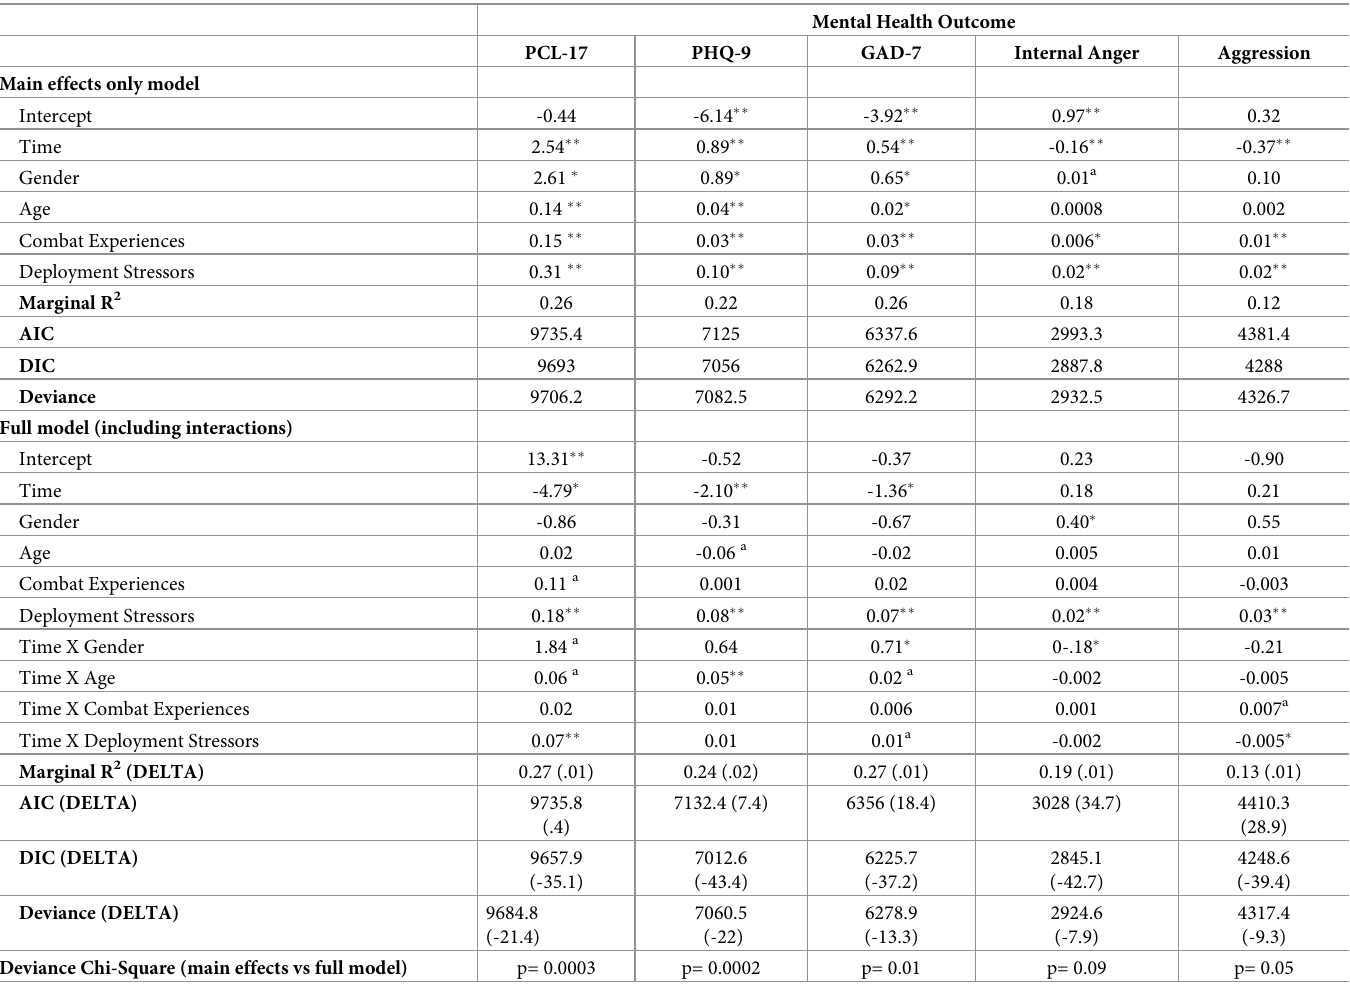
Table 3. Estimates for the multilevel models predicting each mental health